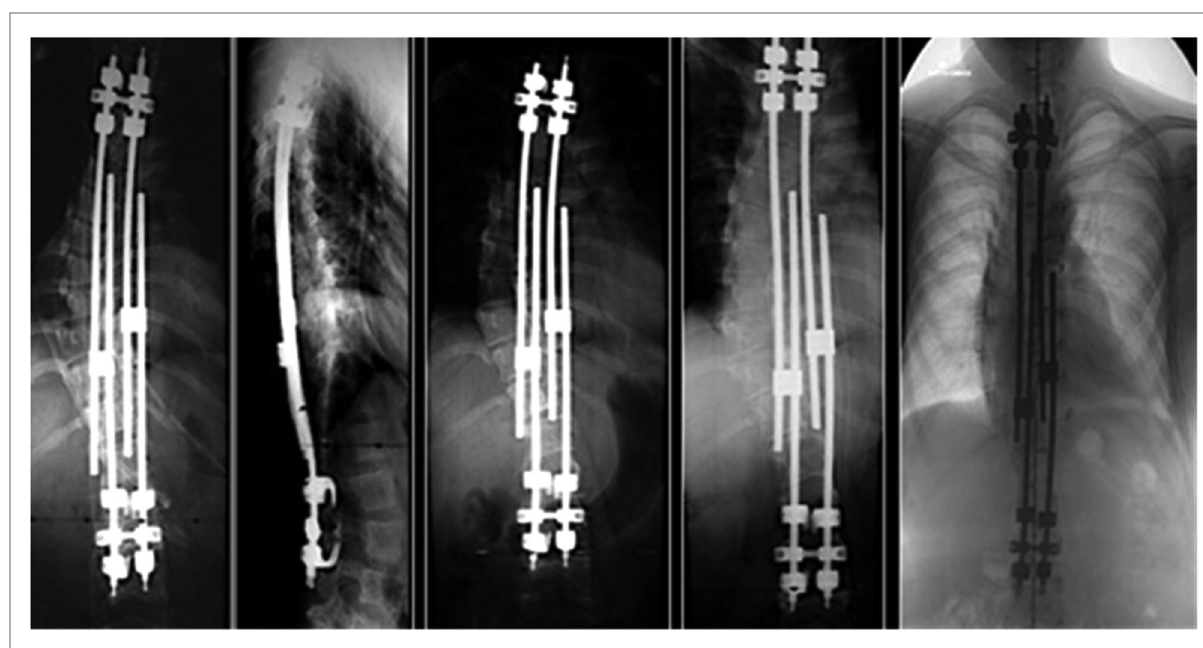
FIGURE 1 Four-year lengthened growing rods in a patient affected by Marfan ’ s